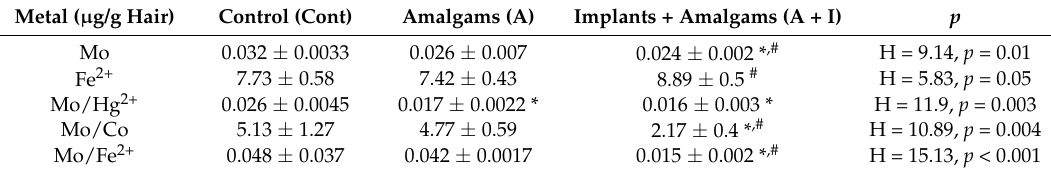
Table 2. Mean values for Mo, Fe 2+ , and Mo/Fe 2+ , Mo/Co ratios between groups ( µ g/g hair). Metal (µg/g hair)